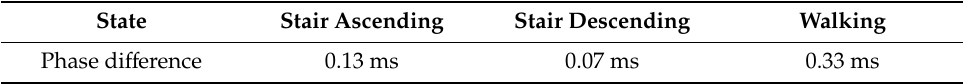
Table 1. Phase di ff erence between knee LBKA and